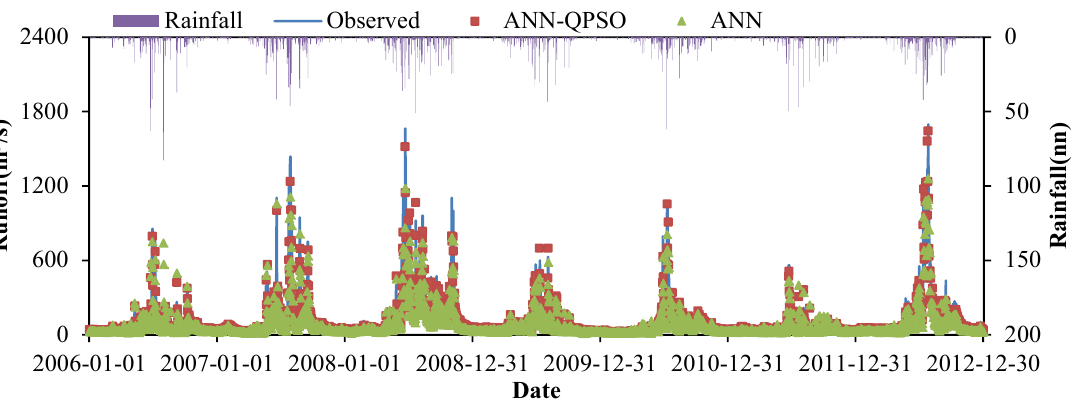
Figure 8. ANN, ANN-QPSO forecasted data and observed runoff data during the training